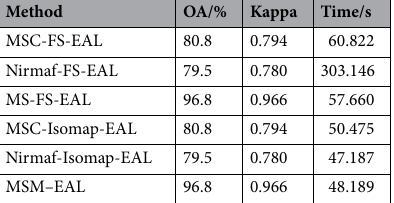
Table 4. EAL framework classification results after different spectral processing.